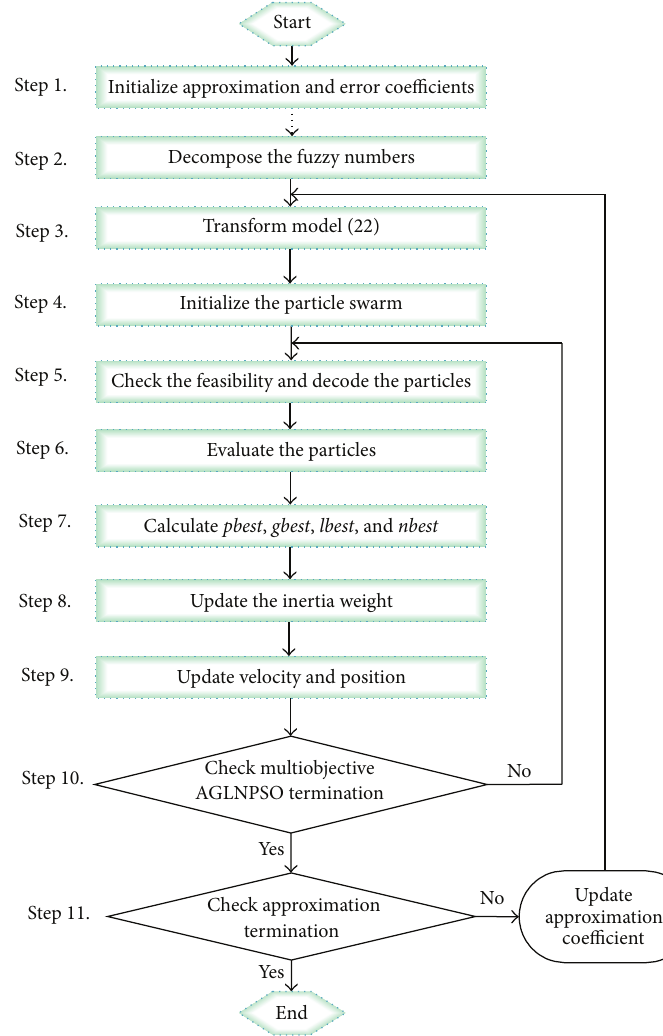
Figure 5: Overall procedure of the proposed